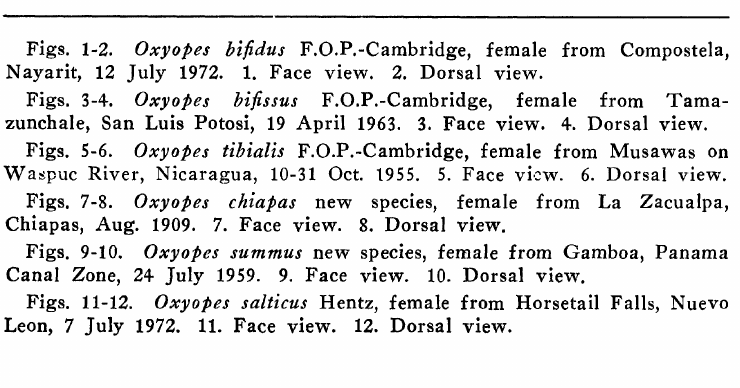
Figs. 1-2. Oxyoles bifldus F.O.P.-Cambridge, female from Co.mpostela, Nayarit, 12 July 1972. 1. Face view. 2. Dorsal view. Figs. 3-4. Oxyoes bifissus F.O.P.-Cambridge, female from Tama- zunehale, San Luis Potosi, 19 April 1963. 3. Face view. 4. Dorsal view. Figs. 5-6. Oxyoles tibialis F.O.P.-Cambridge, female from Musawas on Waspuc River, Nicaragua, 10-31 Oct. 1955. 5. Face view. 6. Dorsal view. Figs. 7-8. Oxyoes chialas new species, female from La Zaeualpa, Chiapas, Aug. 1909. 7. Face view. 8. Dorsal view. Figs. 9-10. Oxyoles summus new species, female from Gamboa, Panama Canal Zone, 24 July 1959. 9. Face view. 10. Dorsal view. Figs. 11-12. Oxyolaes salticus Hentz, female from Horsetail Falls, Nuevo Leon, 7 July 1972. 11. Face view. 12. Dorsal